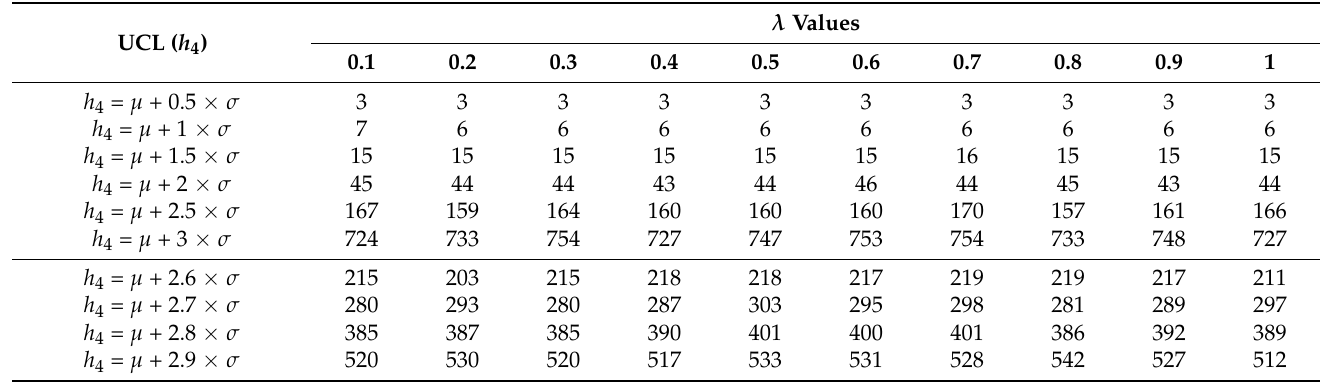
Table 11. ARL values under different MEWMA parameters.